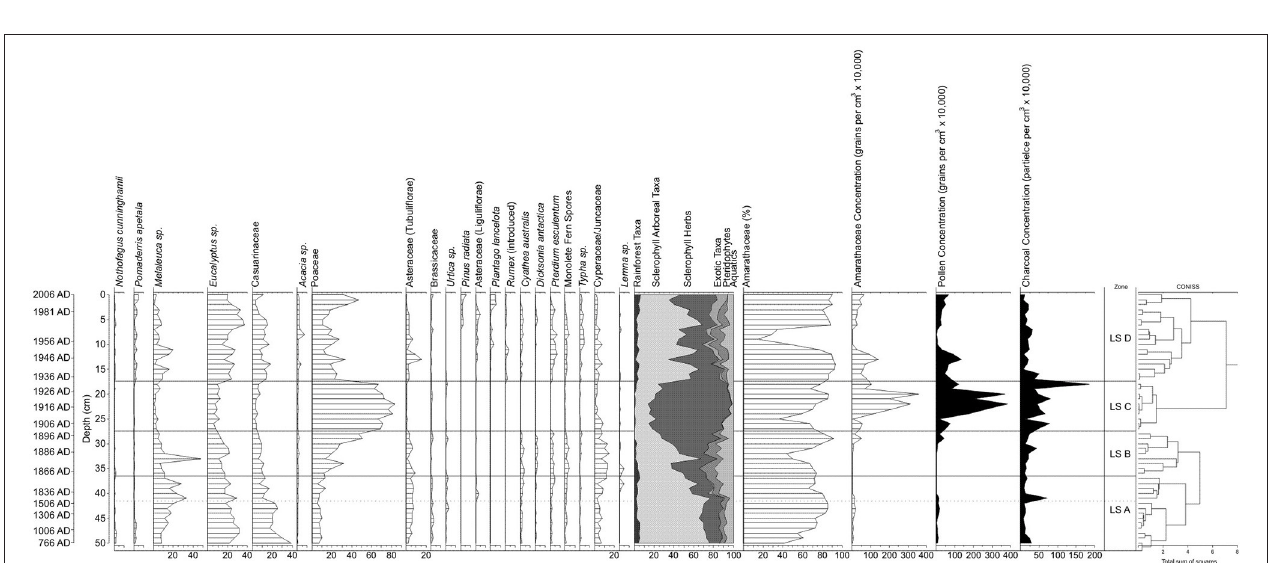
FIGURE 2 | Chronostratigraphy of the core based on 14 C AMS ages, 210 Pb ages, 137 Cs spike, geochemical (i.e., lead, copper, and zinc reflecting the occurrence of mining/refining within Tasmania and more broadly across South East Australia) and palynological markers. Original figure was presented in the supplementary figures (SA2) of the Gehrels et al. (2012) paper.